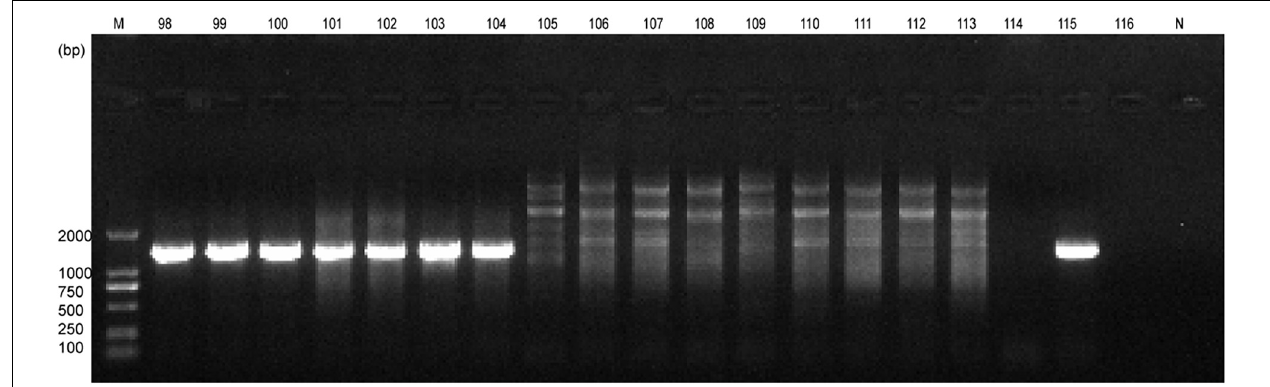
FIGURE 1 | Results of electrophoresis of the amplicons for part samples by PCR with common primers. Lanes 98–116: the sample no. horse blood. N, negative control.